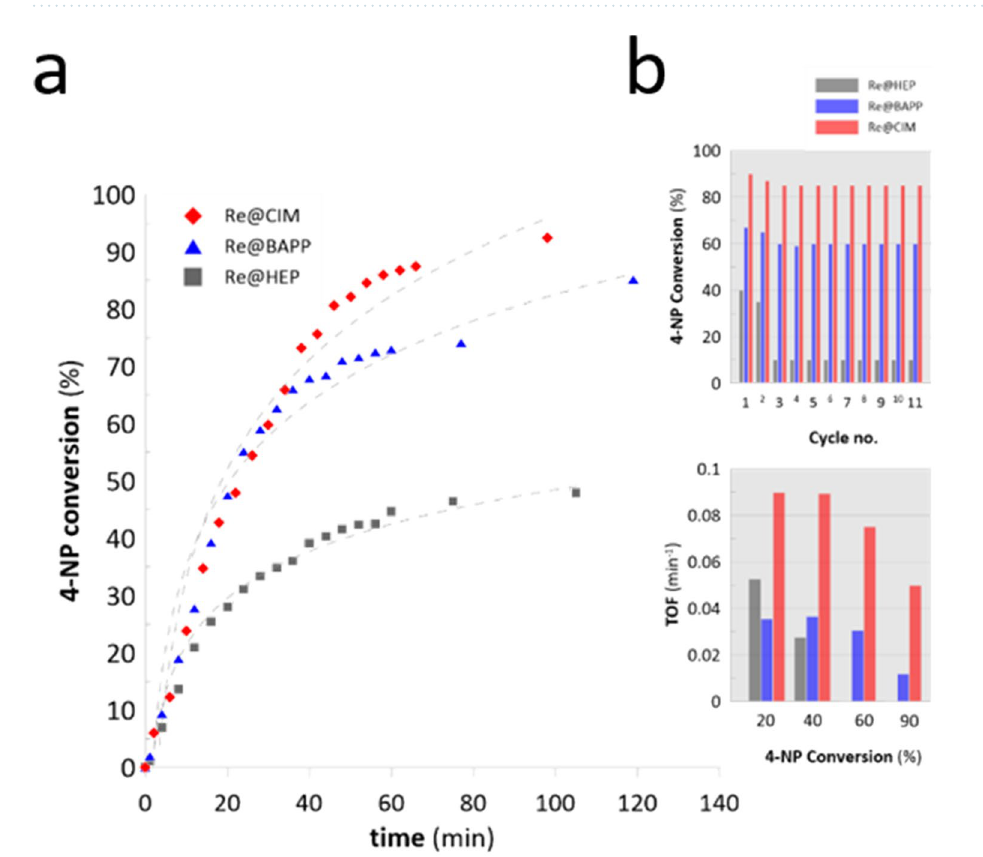
Figure 7. ( a ) 4-NP conversion over time in the first catalytic cycle, ( b ) 4-NP conversion over 11 catalytic cycles, and the TOFs achieved using 5 mg of NCats in the 1st catalytic